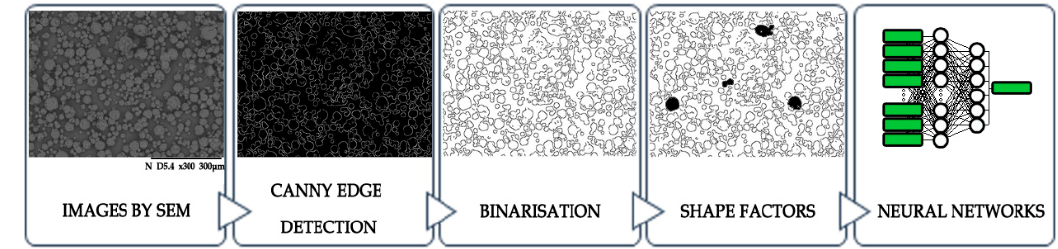
Figure 2. Scheme of shape factors which were extracted of image to the learning process of Neural Networks.